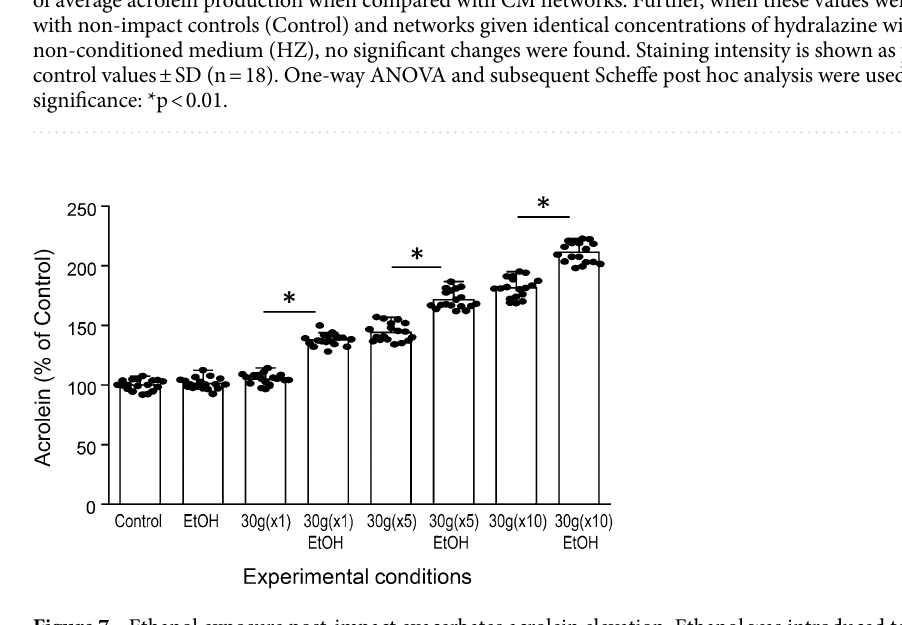
Figure 7. Ethanol exposure post-impact exacerbates acrolein elevation. Ethanol was introduced to demonstrate the system’s capability to easily investigate potential comorbidities. Networks experiencing rapid (5 s) 30 g impacts in single, ×5, or ×10 quantities were exposed to 40 mM EtOH for a duration of 15 min immediately (~ 2 min) following injury (30 g(× 1)EtOH, 30 g(×5)EtOH, and 30 g(×10)EtOH, respectively) and compared with identical, EtOH-absent treatments (30 g(×1), 30 g(×5), and 30 g(×10), respectively). ICC for acrolein-Lys adducts was performed at 24 h post-injury. EtOH significantly increased acrolein levels compared to non- EtOH exposed impact-networks of force and quantity matched impact forces in all cases. Non-impact control networks with and without EtOH (Control and EtOH, respectively) showed no significant differences. Staining intensity is shown as percent control values ± SD (n = 18). One-way ANOVA and subsequent Scheffe post hoc analysis were used to determine significance: *p <